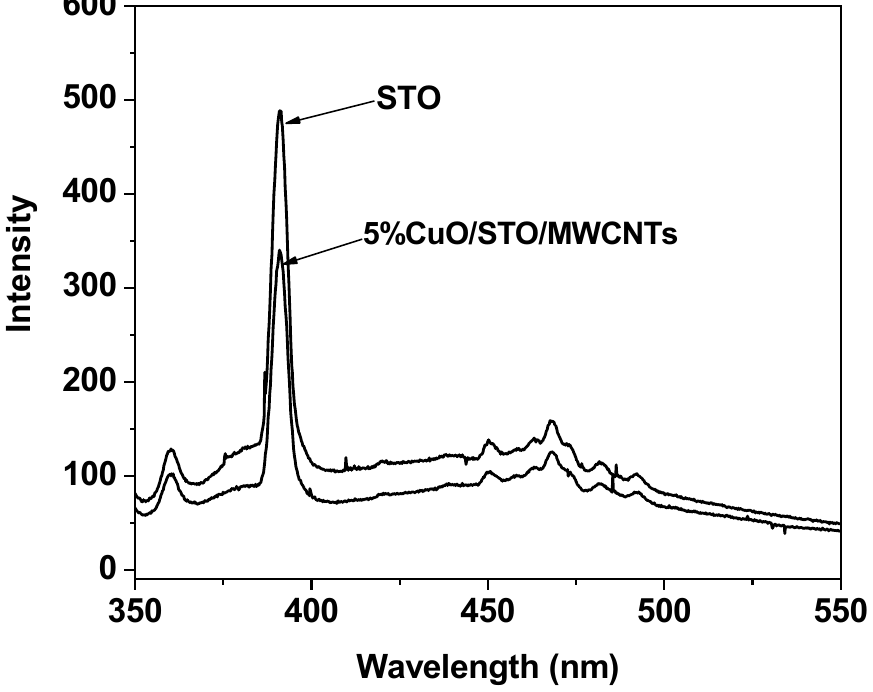
Figure 15. PL spectra of STO and 5% CuO/STO/MWCNTs.